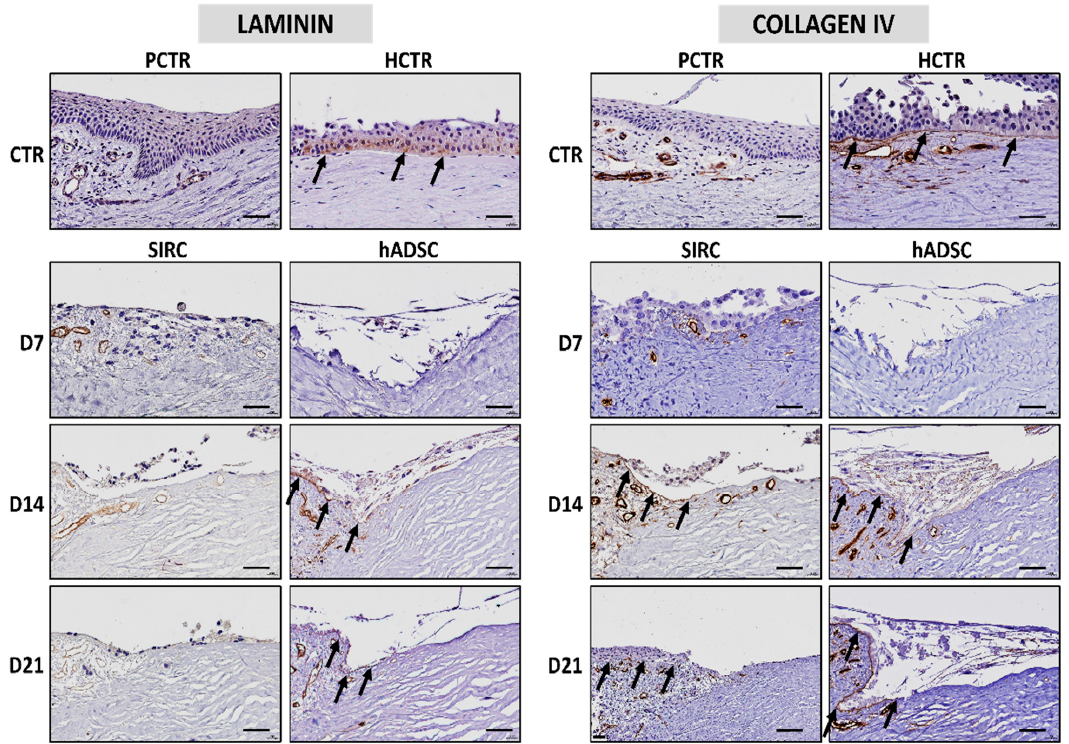
Figure 7. Immunohistochemical analysis of the basement membrane markers laminin and collagen IV in RLs recellularized with SIRC cells and hADSCs at days 7 (D7), 14 (D14), and 21 (D21) of follow ‐ up, porcine native limbus (PCTR), and human native limbus (HCTR). Illustrative areas of the basement membrane stained by the immunohistochemical procedure are highlighted with arrows. Scale bars: 50 μ m.